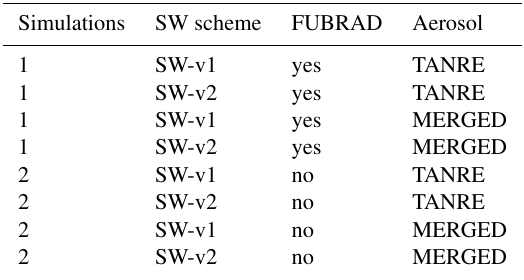
Table 1. Radiation setups (modified heating rates due to the erup- tion of Mt.Pinatubo) used for testing the new radiation infrastruc- ture. Both simulations cover the years 1991–1993. Varied parame- ters are the shortwave scheme (SW-v1 or SW-v2), the selection of the FUBRAD radiation scheme, and the selected aerosol input to AEROPT (TANRE or